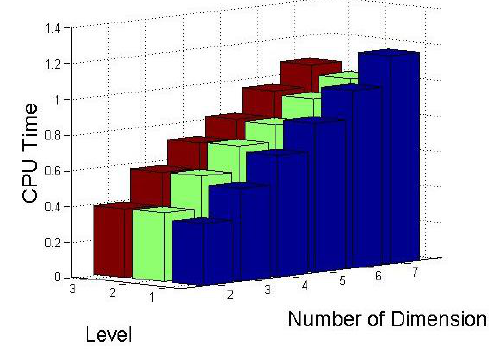
Figure 12. Time complexities of different levels of the algorithm are almost the same.